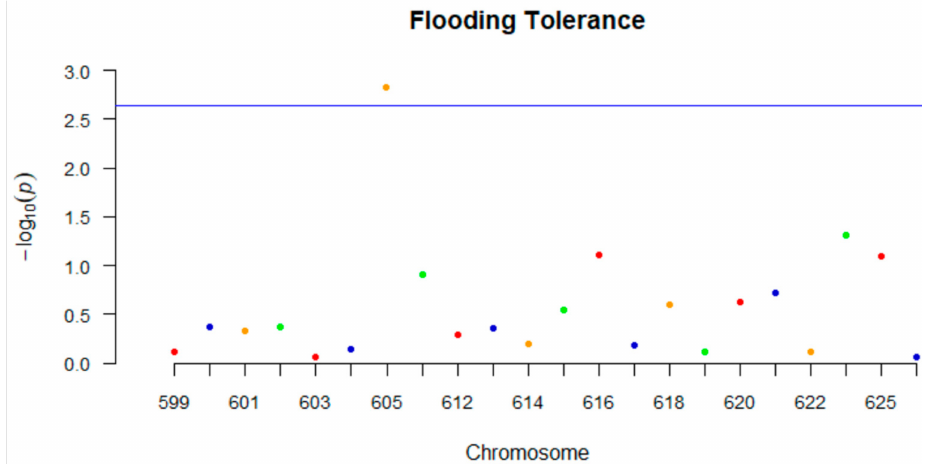
Figure 3. Manhattan plot of the results from the Mini-GWAS meta-analysis: The y -axis represents –log (two-sided p values) for association of variants with flooding tolerance from the meta-analysis. In the x -axis, the molecular marker codes (GSM0XXX) are represented. The horizontal blue line represents the threshold for genome-wide